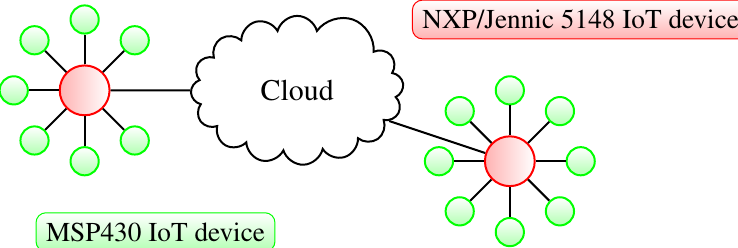
Figure 2. Star topology representation of small heterogeneous IoT networks comprised of MSP430- and NXP/Jennic 5148-based devices connecting directly to the